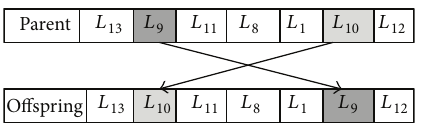
Figure 4: Mutation operation.